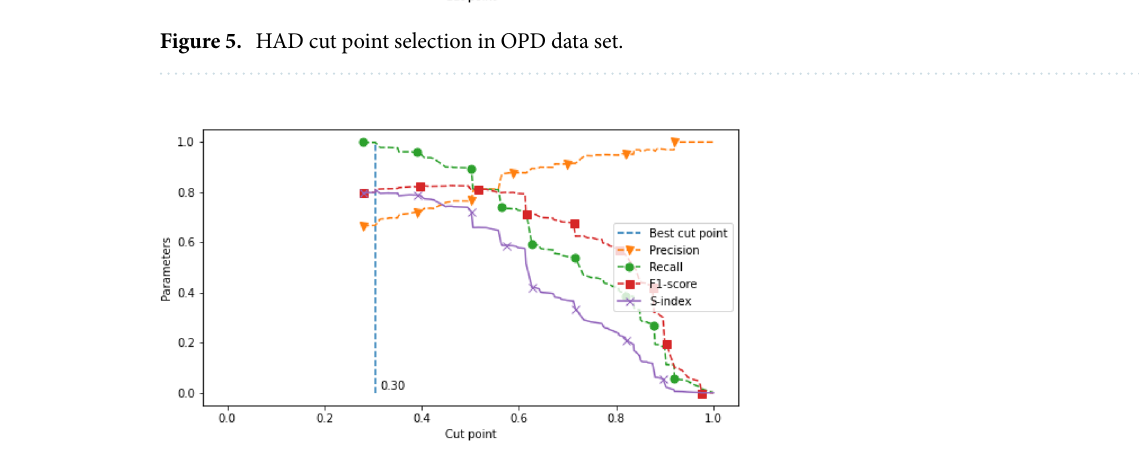
Figure 6. HAD cut point selection in IPD data set.